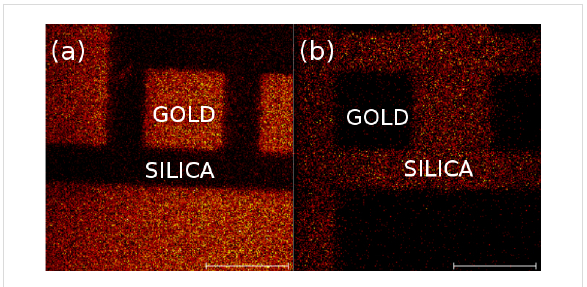
Figure 4: ToF–SIMS fluorine mapping of patterned gold on silica surfaces, orthogonally functionalized with F-thiol + PEG/Si (a) and F-silane + MUA (b). The scale bars are 100 μ